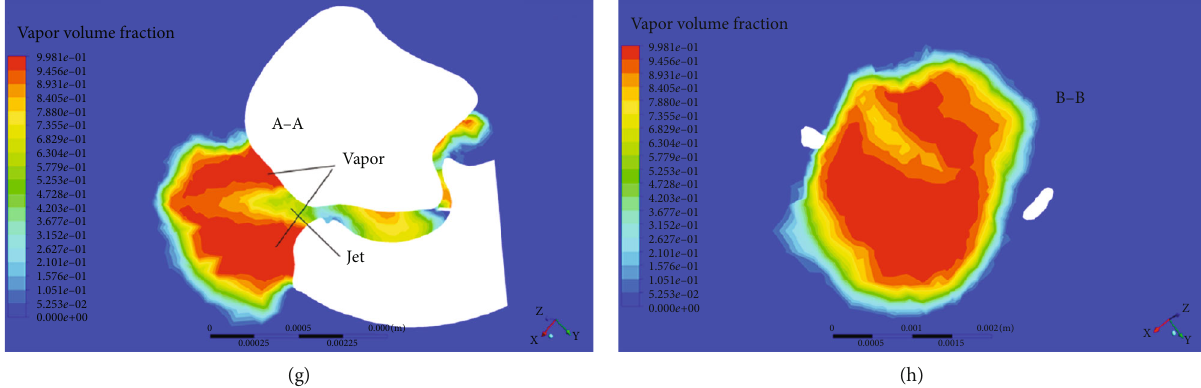
Figure 6: (a) Reference plane for the simulation results, showing the fl ow fi eld of the snapper claw along the nozzle. (b) Contour of the pressure on the claw side when the bubble collapses. The pressure on both sides of the bubble is di ff erent, and the pressure on the bottom is higher. (c) When it is about to burst, the bubble is compressed into a concave shape, pointing to the head of the bubble. (d) Speed vector of the fl ow fi eld. When the bubble bursts, the fl uid on both sides moves toward the middle of the bubble, and the jet velocity from the bottom of the bubble pointing to the head is greater. (e) Picture of the cavitation bubble in the maximum state. The nonspherical bubble includes the jet in the middle and vapor around. (f) Simulation result of cavitation bubble with vapor volume fraction of 50%. (g) Contour of vapor volume fraction along the axis of the bubble. (h) Contour of vapor volume fraction along the radial cross-section of the